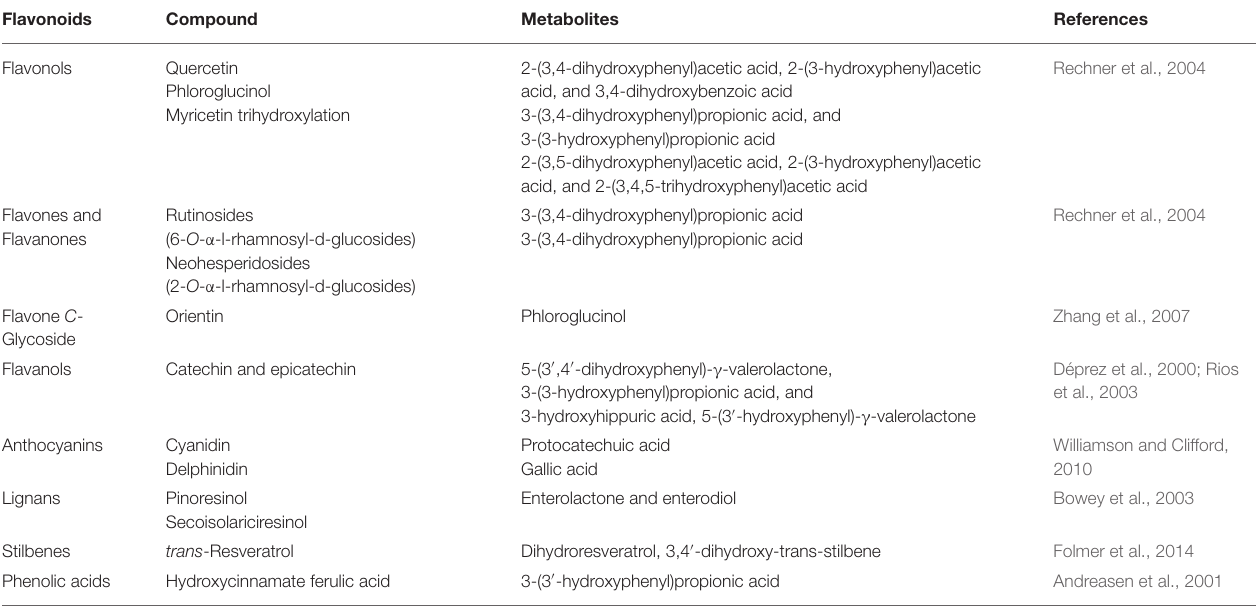
TABLE 1 | A shortlist of the most encountered pomace active compounds and their fate within the digestive